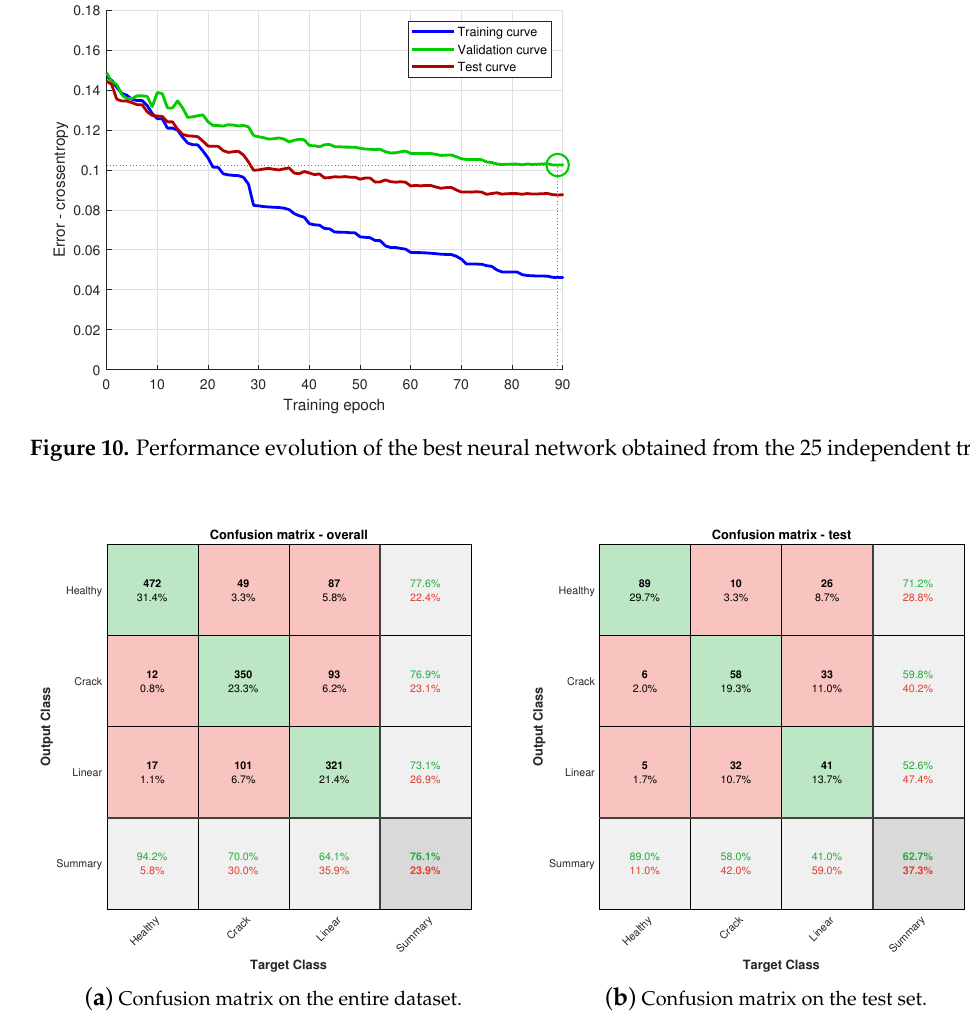
( b ) Confusion matrix on the test set.